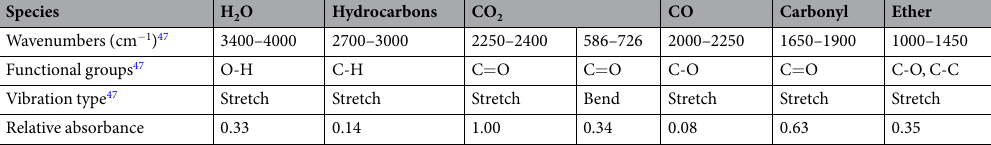
Table 7. TGA-FTIR analysis of peanut hulls during heating.